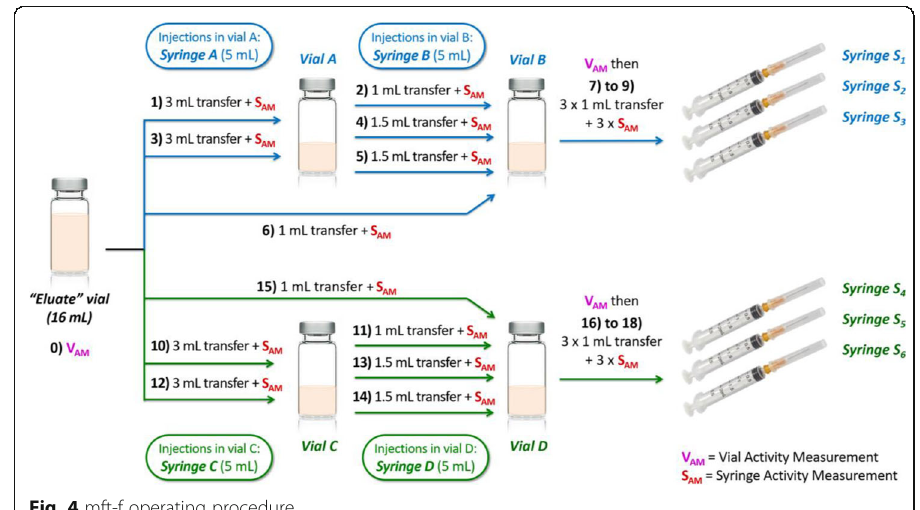
Fig. 4 mft-f operating